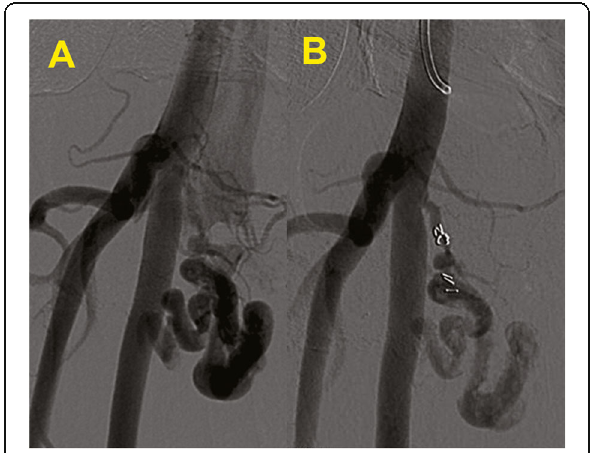
Fig. 4 a-b Arteriovenous fistula (AVF). Angiography ( a ) demonstrate a small fistula tract between the origin of the superficial femoral artery and vein; the tract has been embolized with microcoils with a significant reduction of blood flow through the fistula at the angiography performed immediately after the embolization ( b